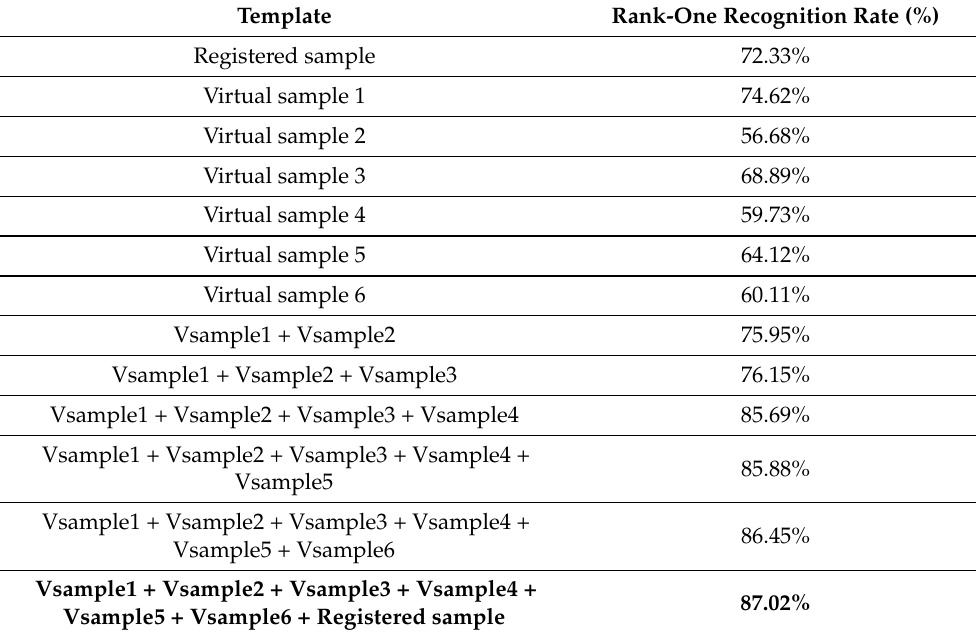
Table 2. Identification performance of different virtual